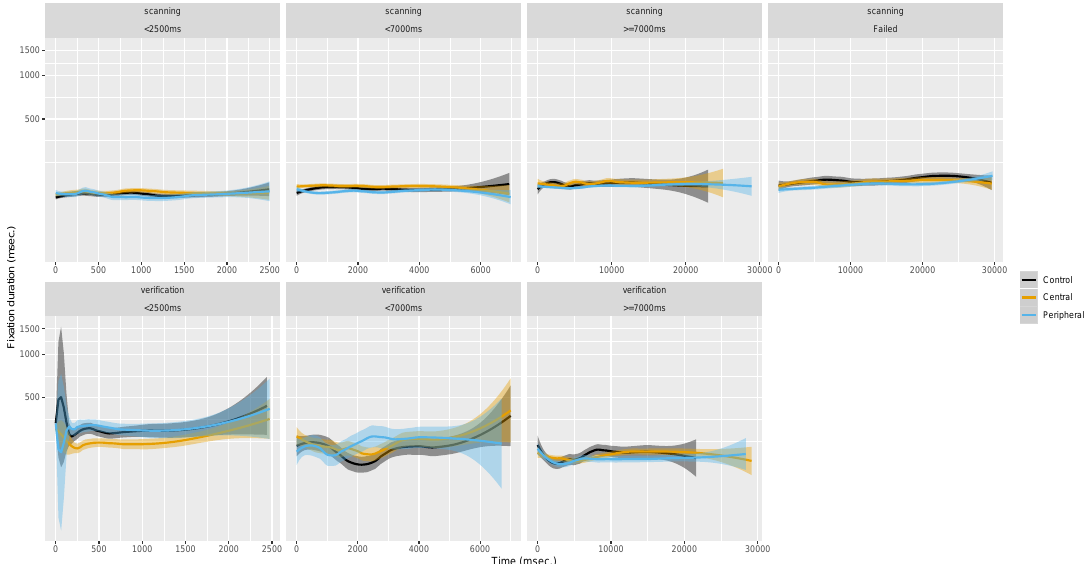
Figure A10. Time-course of average fixation duration during saccades as a function of phase search (trial duration subgroups do not overlap). Ribbons show 95%CI. Control condition appears in black, central in orange and peripheral in